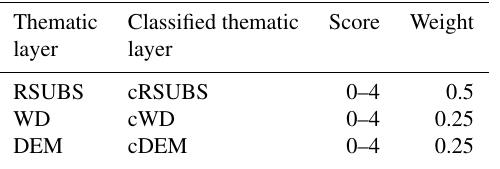
Table 2. Thematic layer classification: upper and lower bounds of the classes and related